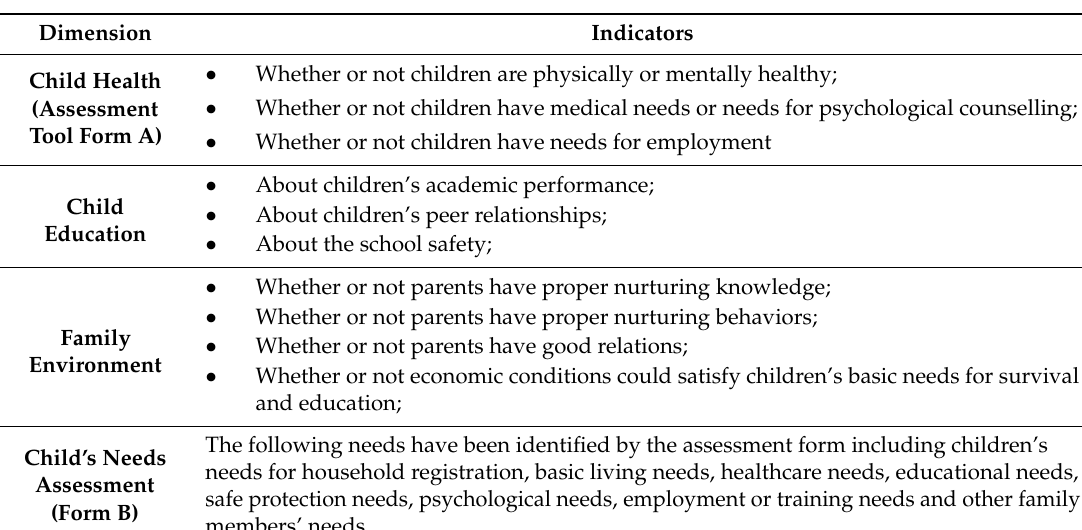
Table 1. The dimensions and indicators of the assessment tools of the INGO supported Child Welfare Project in